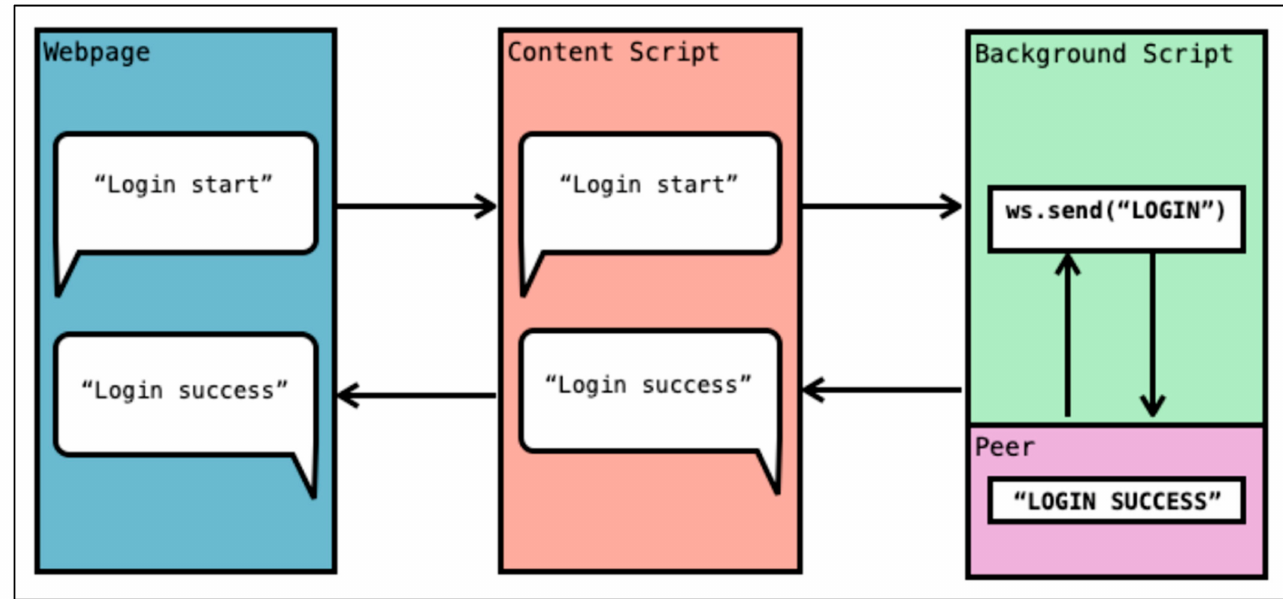
Figure 6. Intra-extension communication within Bingo